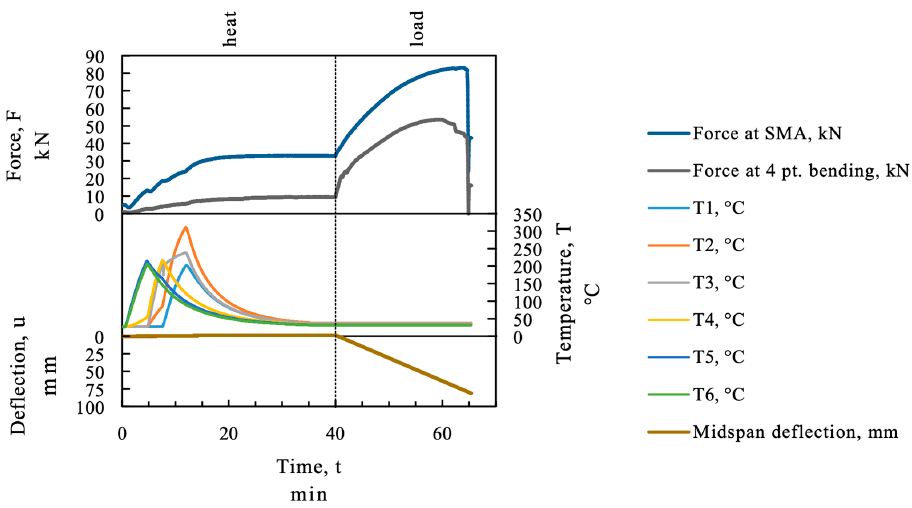
Figure 8. Temperature and recovery force at the SMA strip; beam SMA_1.